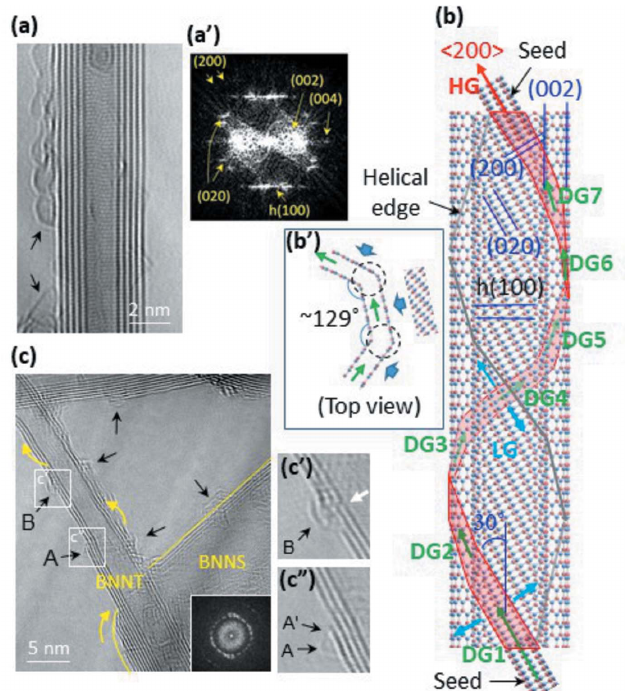
Figure 3 HRTEM images and the helical-growth model of BNNTs. ( a ) An HRTEM image of a BNNT. ( a 0 ) The FFT pattern obtained from the HRTEM image in ( a ). ( b ) The helical-growth model for a BNNT ( AA h BN helix with a zigzag structure) based on those of MWNTs (Lee et al. , 2013) and SWNTs (Lee et al. , 2014). An AA h BN nanoribbon seed (bottom) initiates and leads to helical growth comprising seven diagonal growths, which is assumed to adopt the heptagon cross-sectional morphology of an MWNT (Fig. S1). HG, DG and LG in ( b ) indicate helical growth, diagonal growth and lateral growth, respectively. ( b 0 ) A schematic explaining the facet growth of BN layers to maintain crystallinity. ( c ) An HRTEM image of a BNNT sample. The yellow arrows indicate left-handed scrolling. ( c 0 ), ( c 00 ) Magnified images of the squares in ( c ). A 0 in ( c 00 ) indicates a disconnected layer. The white arrow in ( c 0 ) indicates helical edges where all of the wall layers are disconnected. The black arrows in ( a ) and ( c ) indicate the traces of mono-layer BN.